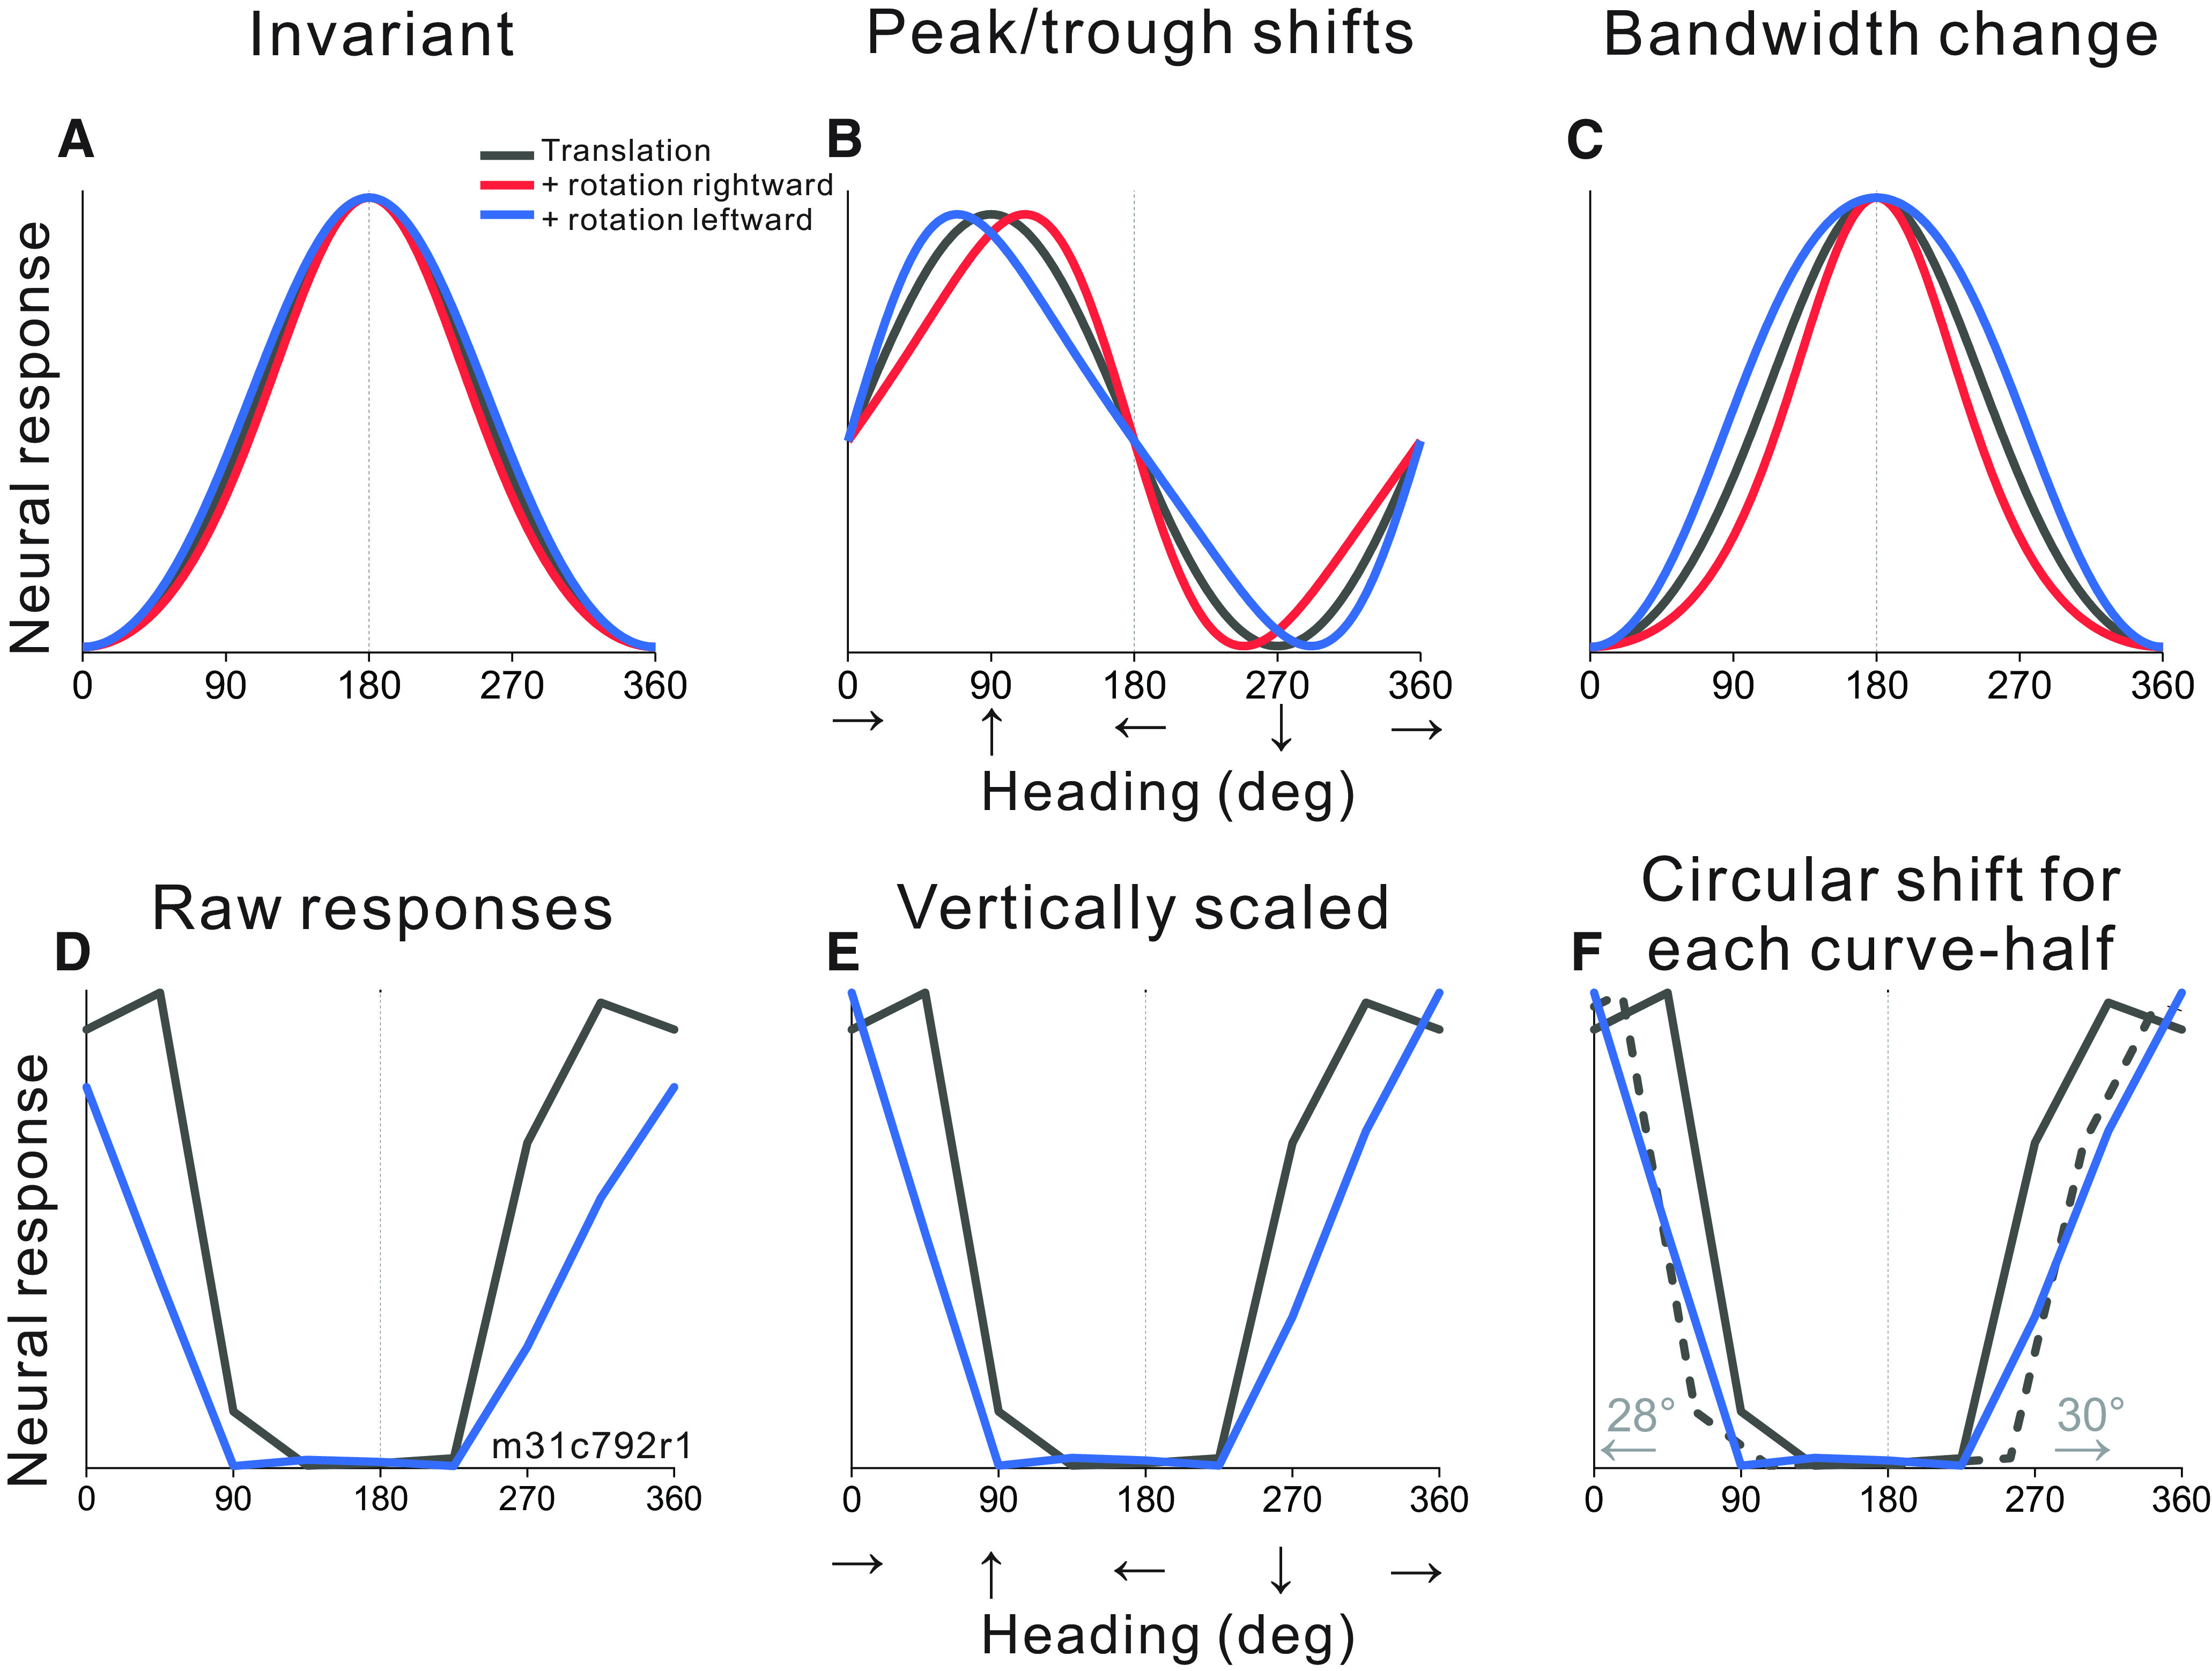
Quantifying the effect of eye rotation on heading tuning curves. A–C, Schematic illustration of possible effects of eye rotation. Black curves represent responses to pure translation. Red and blue curves represent responses to combinations of translation and either rightward or leftward rotation, respectively. A, Schematic illustration of complete compensation for eye rotations. B, Schematic tuning of a cell with a forward heading preference (90°) that does not compensate for rotation, producing shifts of the peak and trough of the tuning curve in opposite directions. C, Schematic tuning of a cell with a lateral heading preference (180°, leftward) that does not compensate for rotation resulting in changes in tuning bandwidth without a shift in the heading preference. D–F, Illustration of steps in the computation of partial shifts. D, Tuning curves from a neuron responding to simulated translation and simulated rotation in the 2D environment. E, Both tuning curves are linearly interpolated and the translation+rotation tuning curve (blue) is vertically scaled and shifted to match the range of responses in the pure translation curve (black). F, Dashed lines indicate circularly shifted segments of the pure translation tuning curve that minimize the sum of squared error in each half of the translation+rotation tuning curve (0:180°, 180:360°). Partial shifts are indicated with arrows. Panels B, C, F show that the expected direction of the shift for each tuning curve half does not depend on heading preference.